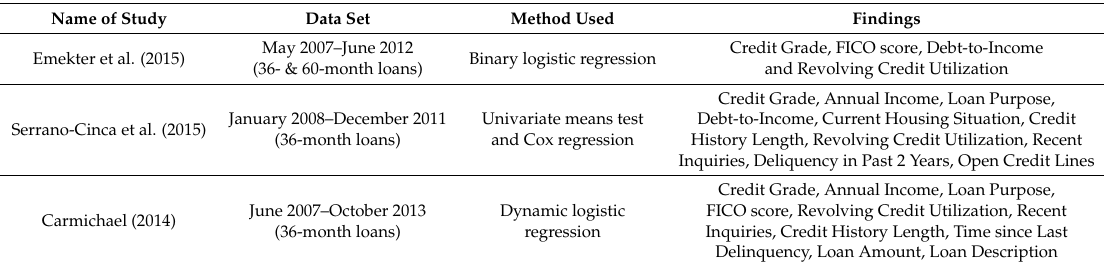
Table 1. Summary of Borrowers’ Default